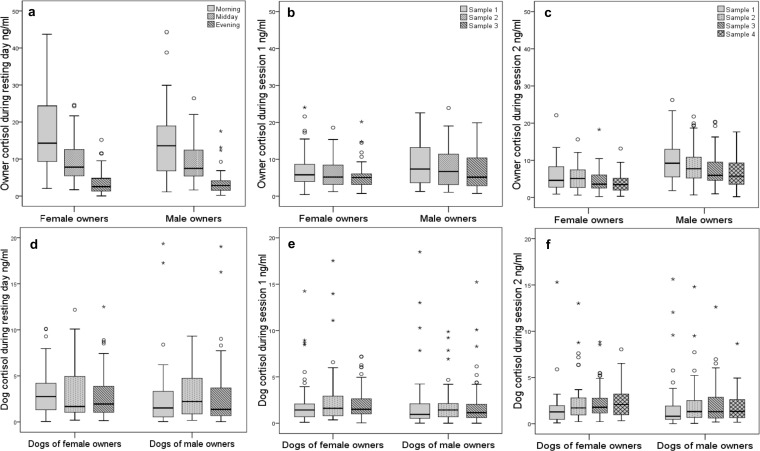
Changes in cortisol in owners and dogs.Cortisol concentration during the resting day, during the first session and second session in owners (a, b, c) and their dogs (d, e, f). Median, interquartile range, upper and lower whiskers and outliers are given.